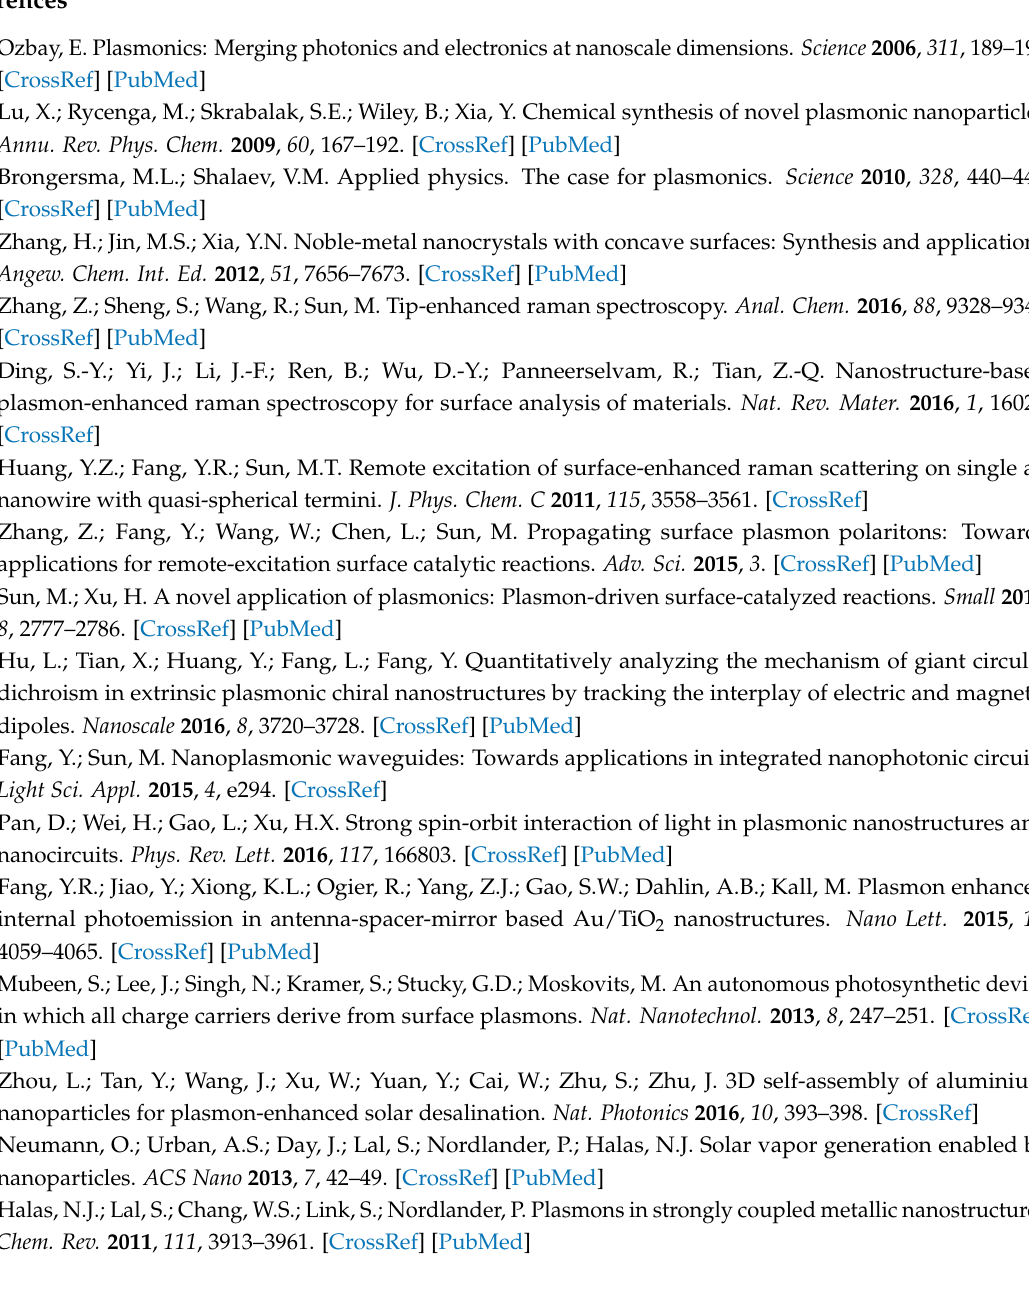
Figure S1: experimented and simulated dark-field scattering spectra of nanorice. Figure S2: Schematic drawing of the dark-field setup and the geometry used in the